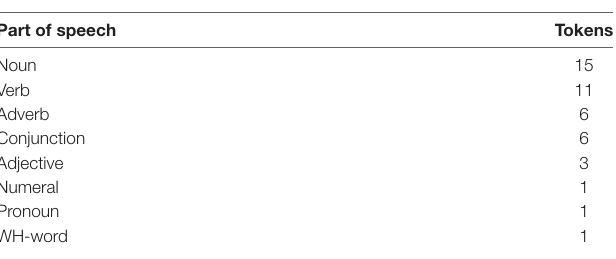
TABLE 1.1 | Source signs of spreading.